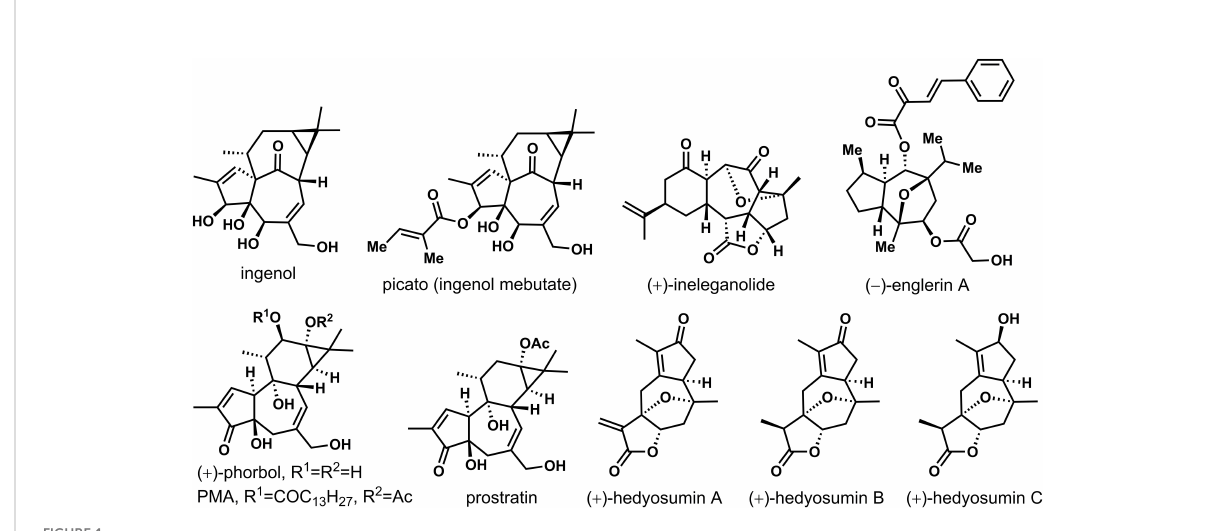
FIGURE 1 Several active natural products with seven-membered carbon